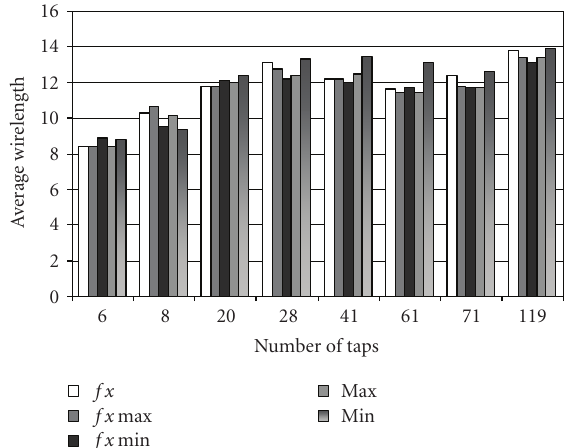
Figure 18: Average wirelength versus filter size. for various cost functions discussed in Section 4.3 with f x being the modified CSE algorithm presented in Algorithm 1 and others based on maximizing or minimizing AMC. f xmin is the best scenario that results in the minimum number of routing